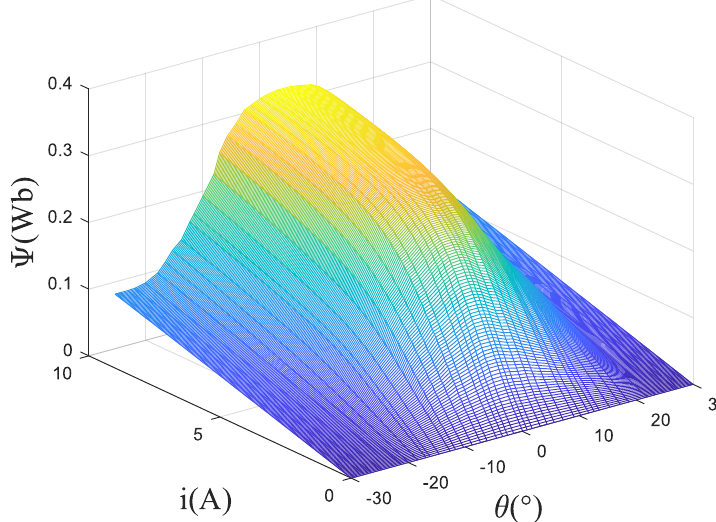
Figure 3. 3D curve of flux linkage relative to the rotor angle and current.